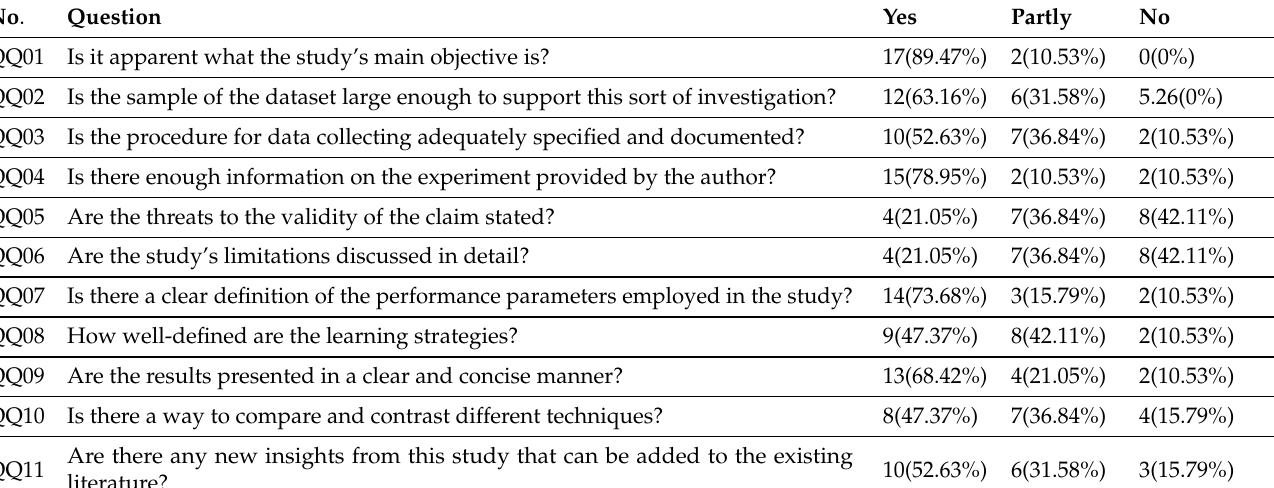
Table 4. Results of the quality